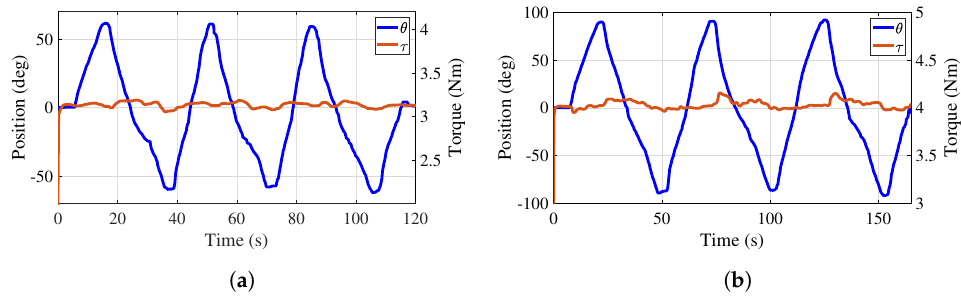
Figure 12. Active phase. Trajectory tracking and total torque behaviors with load. ( a ) Torque at 3.1 Nm. ( b ) Torque at 4